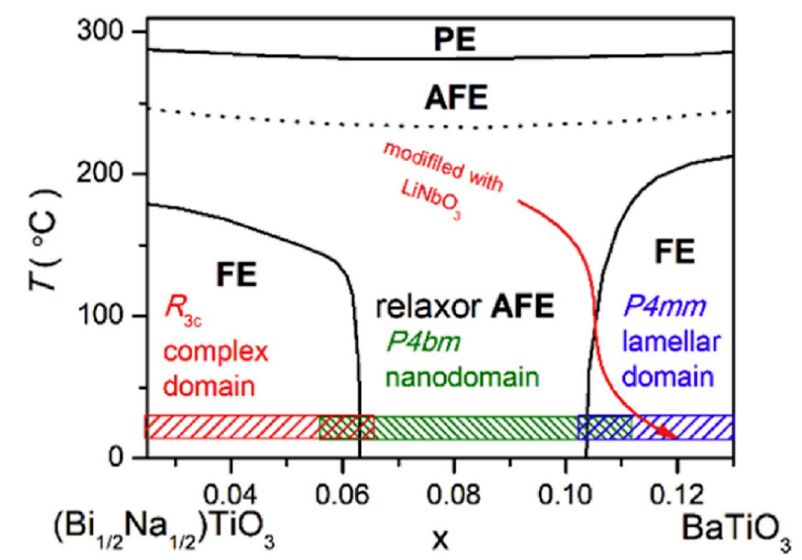
Figure 9. Phase diagram of the (1 − x)(Bi 1/2 Na 1/2 )TiO 3 -xBaTiO 3 ceramics. PE, AFE and FE represent paraelectric, antiferroelectric and ferroelectric phase, respectively. Reprinted with permission from [54]. Copyright 2019 Elsevier Ltd. and Techna Group S.r.l.